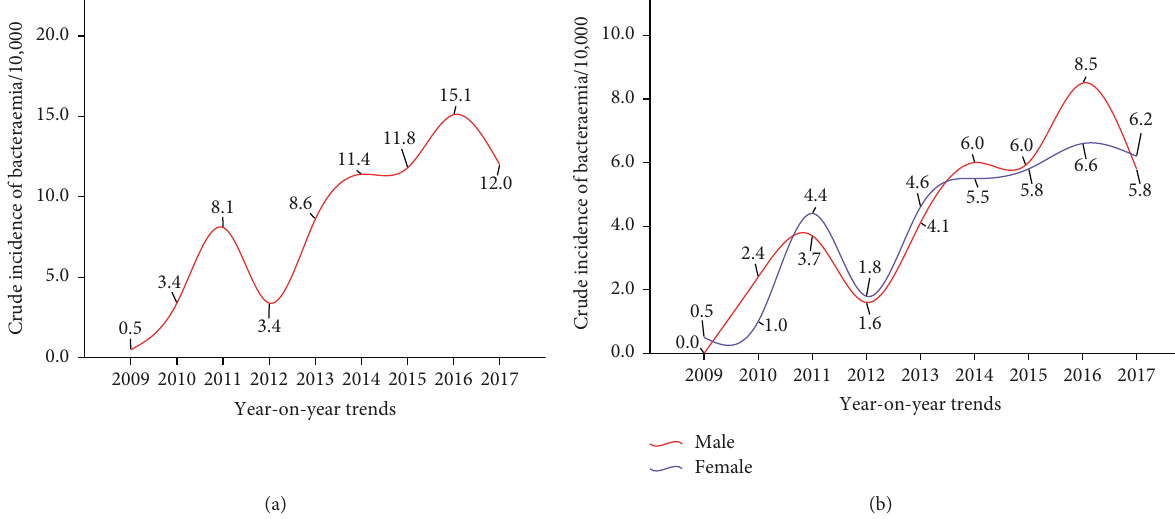
Figure 2: Year-on-year trend of bloodstream bacteraemia reported cases among patients attending St. Dominic Hospital in Akwatia. (a) Trend among all patients/10,000 persons. (b) Gender-specific trend among patients/10,000